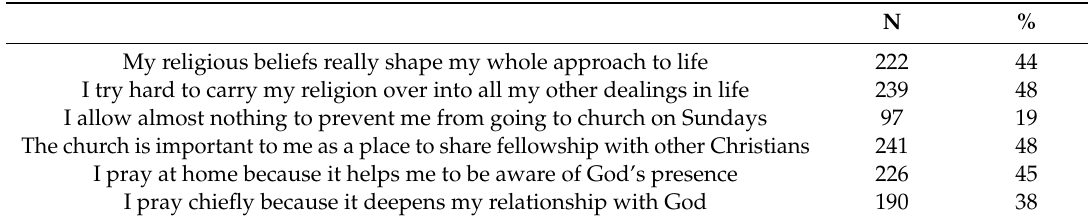
Table 13. Intrinsic religious motivation.